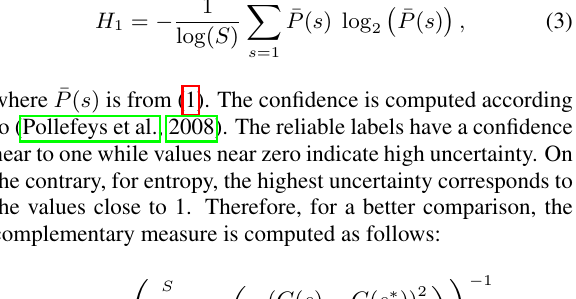
Figure 1. Pipeline for uncertainty evaluation from U-Net predictions and after Markov Random Field